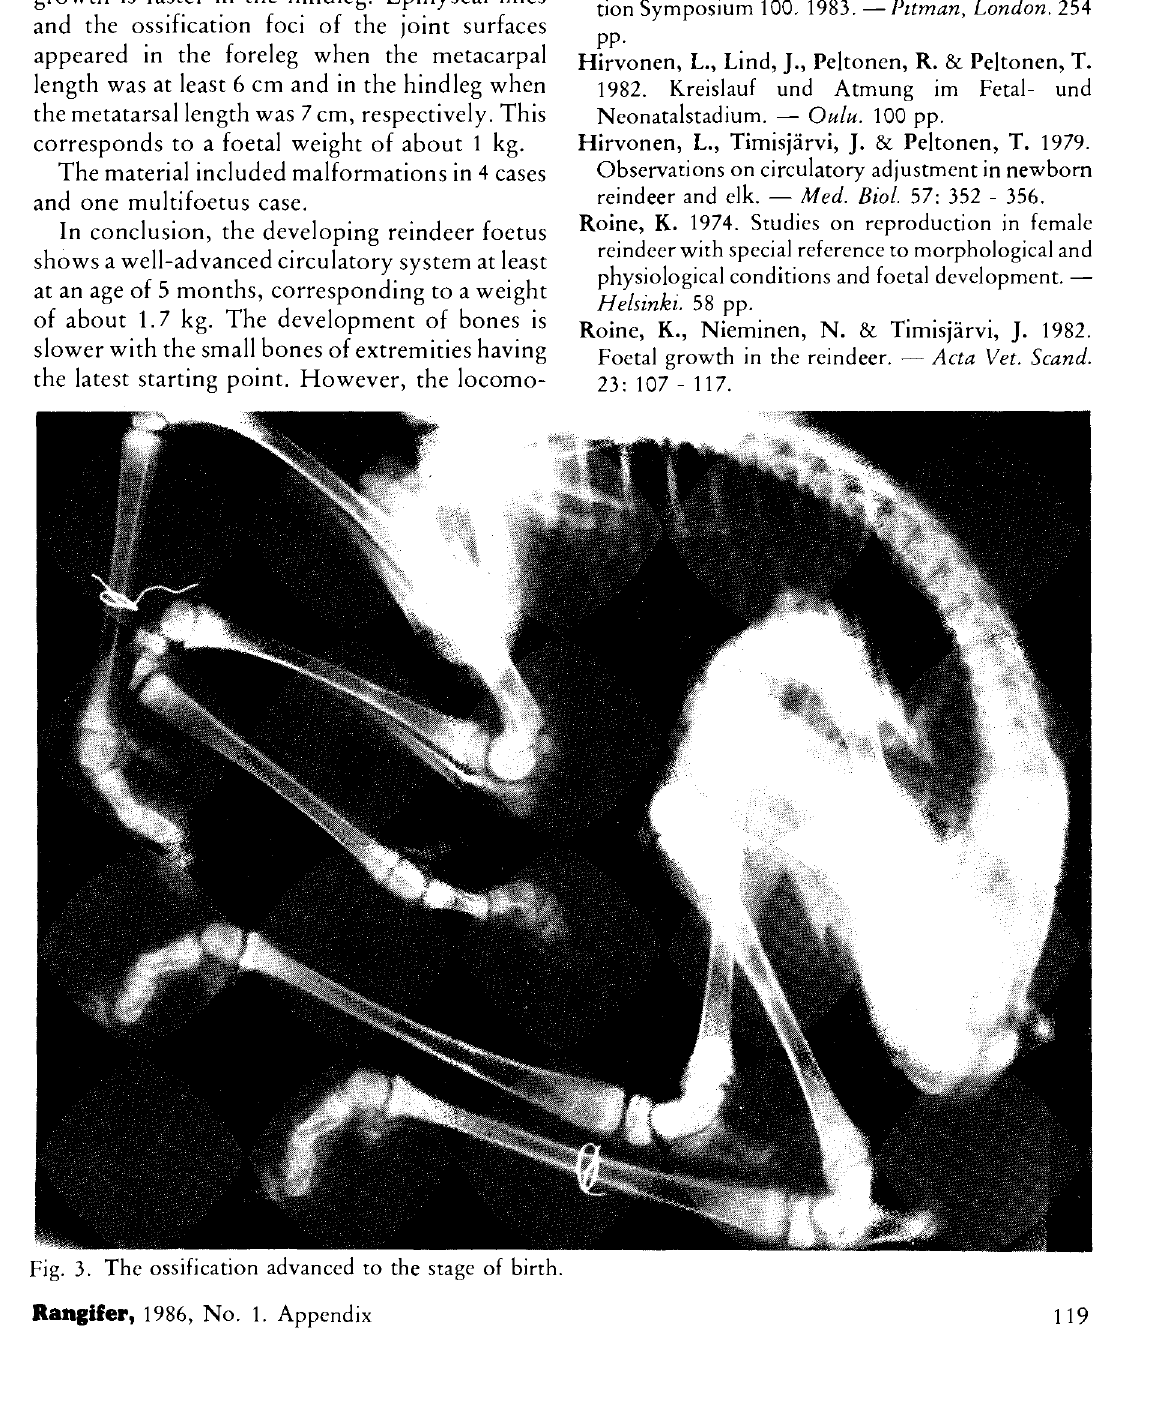
Fig. 3. The ossification advanced to the stage of birth. Rangifer, 1986, No. 1.